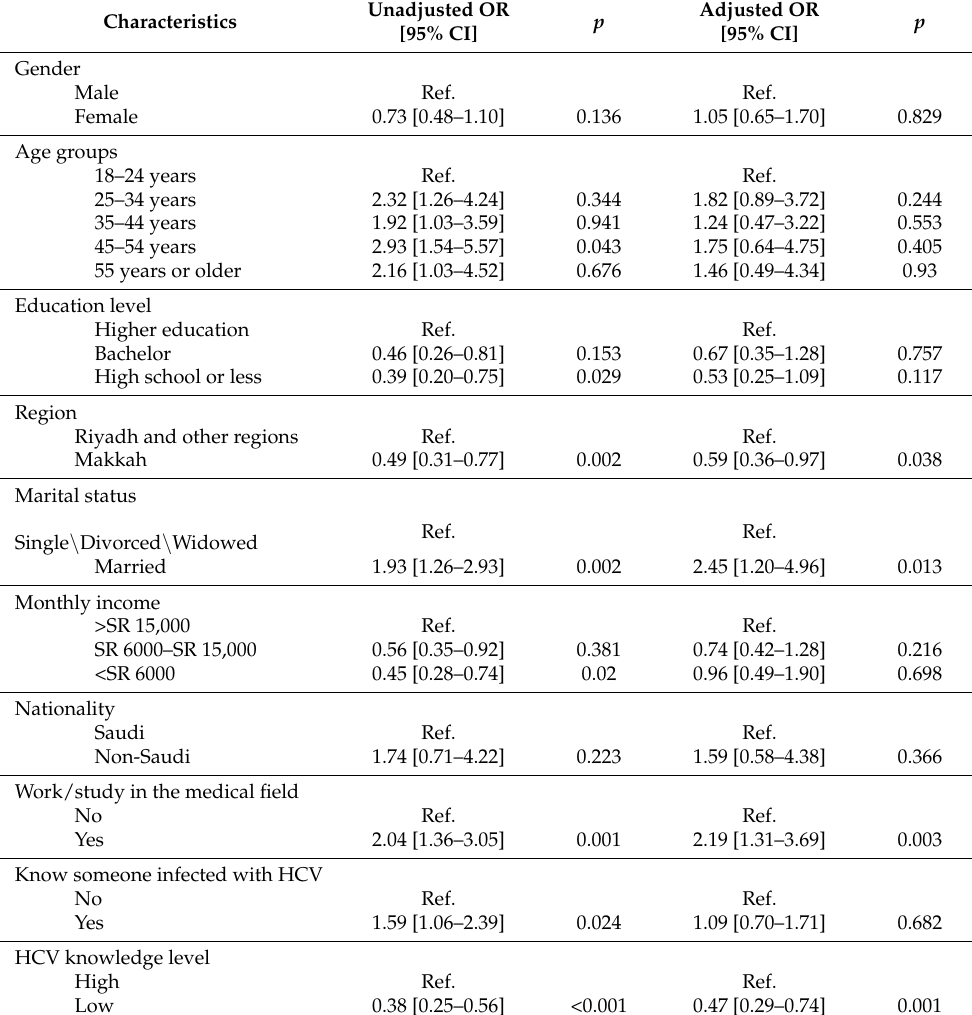
Table 5. Predictors of testing for